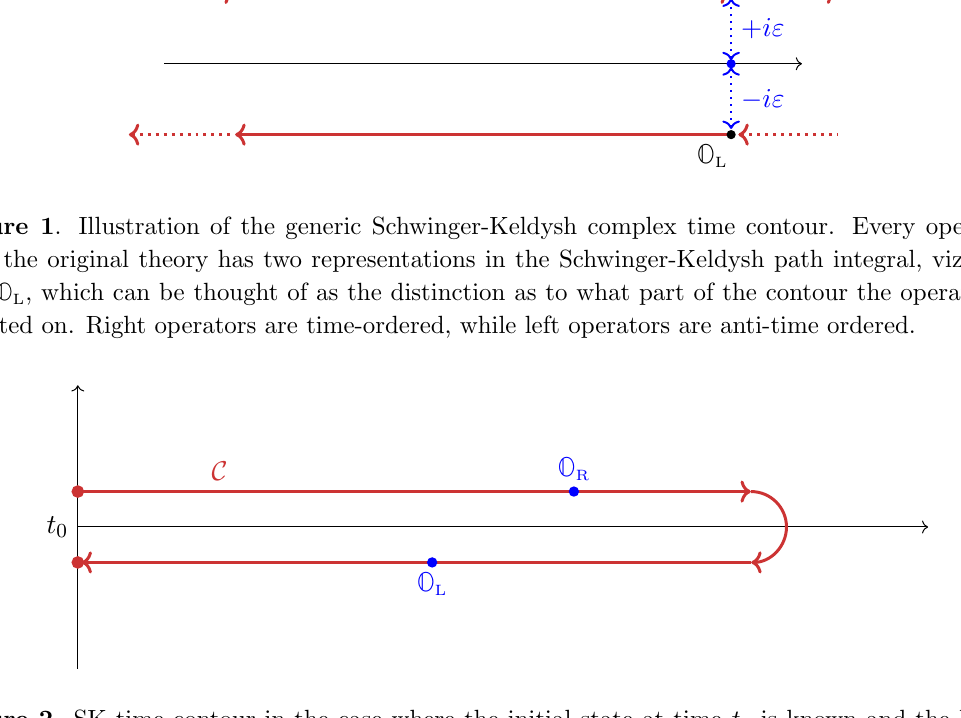
Figure 2 . SK time contour in the case where the initial state at time t 0 is known and the latest operator insertion happens at time t . The indicated operator insertions correspond to a real-time correlator G < ( x; x 0